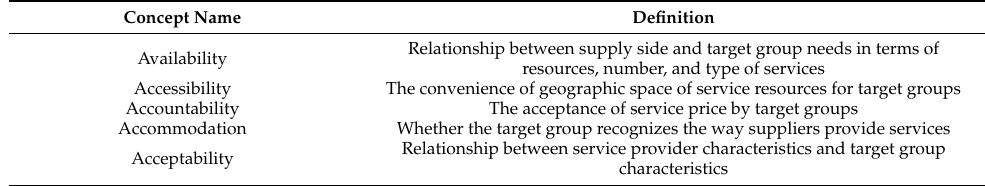
Table 1. Penchansky and Thomas’ five-dimensional measurement.